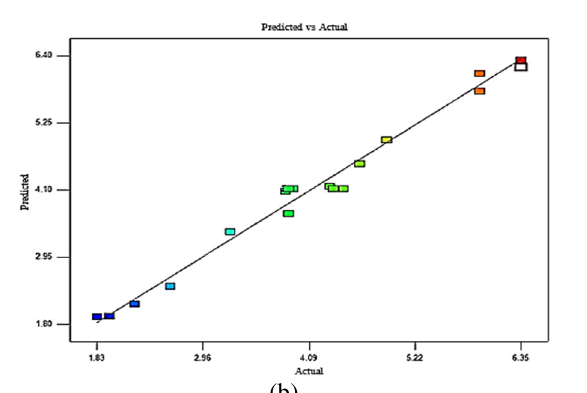
Fig. 5: The plot of Predicted Vs Actual for (a) Ra and